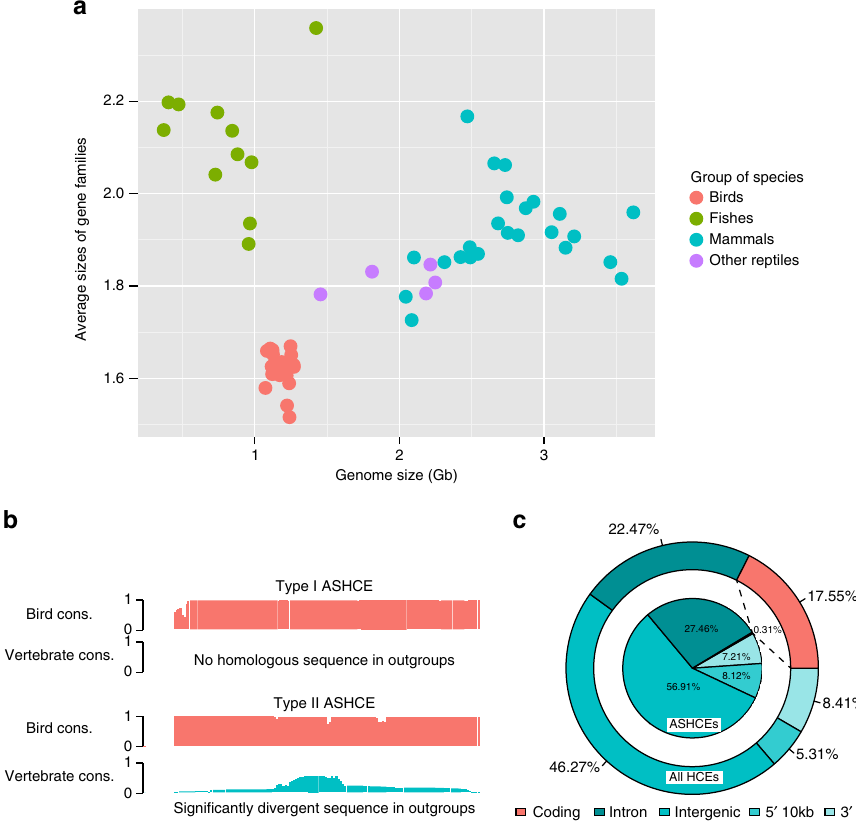
Figure 1 | Characterization of ASHCEs. ( a ) Average sizes of gene families in different vertebrate species. Species in different phylogenetic groups were coloured in different colours. See Supplementary Table 1 for the list of species used in this analysis. ( b ) Illustration of two types of ASHCEs. The type I ASHCEs are conserved in birds but have no homologous sequence in other vertebrate outgroups; the type II ASHCEs are conserved in birds and have rudimentary homologous sequences in outgroup species, but the sequence conservation is significantly low to be detected as homologous between birds and other vertebrates. See Methods section for more details about the identification method of ASHCEs. ( c ) Functional classification of all HCEs and ASHCEs in chicken